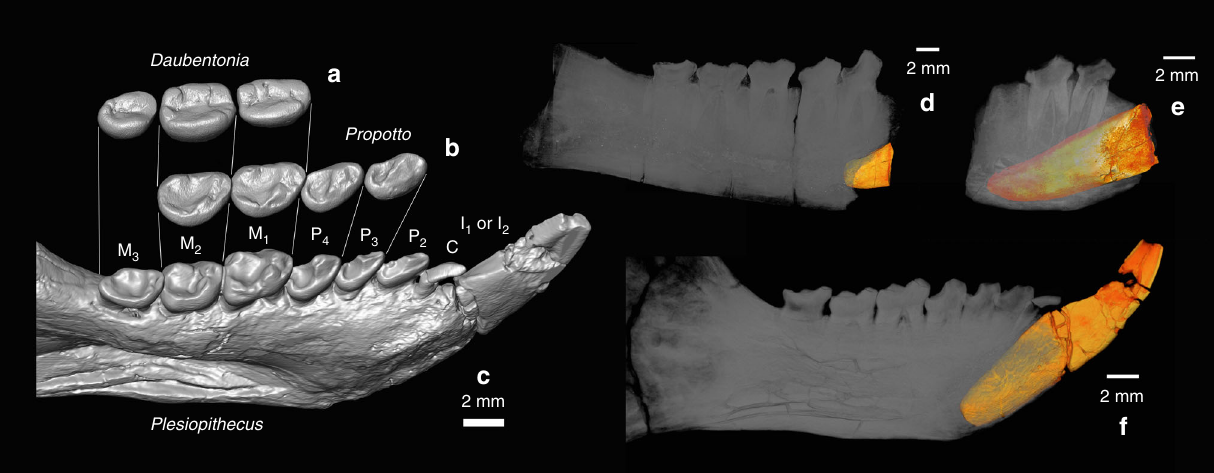
Fig. 2 Comparison of lower molar morphology of Daubentonia , Plesiopithecus , and Propotto , and volume rendering of the enlarged anterior teeth of Plesiopithecus and Propotto . a Left M 1 – 3 of AMNH M-41334, extant Daubentonia madagascariensis , with individual surfaces reoriented slightly to facilitate comparison (teeth are from right side in AMNH M-41334 but are reversed for comparison); b left P 3 -M 2 of Propotto leakeyi (holotype mandible KNM-SO 508, teeth are from right side but are reversed and reoriented slightly to facilitate comparison); c left mandible with I 1 or I 2 and canine-M 3 of Plesiopithecus (DPC 11636). Scale in left panel is for a – c (2 mm). d – f Volume renderings of the enlarged anterior tooth (probable I 1 or I 2 , rendered orange-yellow) in d KNM-KO 101, left mandible with partial root of I 1 or I 2 and crowns of P 3 -M 2 , Propotto leakeyi (early Miocene, Koru, Kenya); e KNM-RU 3690, right mandibular fragment with root and partial crown of I 1 or I 2 and crowns of P 3 – 4 , cf. Propotto leakeyi (early Miocene, Rusinga Island, Kenya); note that in this specimen the root of I 1 or I 2 extends under the roots of M 1 ; f DPC 11636, left mandibular corpus with complete crowns of I 1 or I 2 and canine-M 3